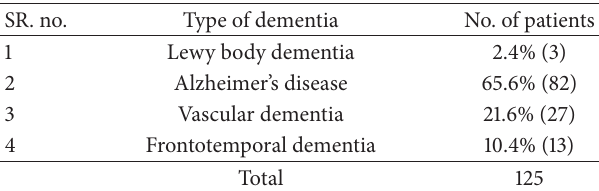
Table 4: Depiction of subtypes of dementia. SR.